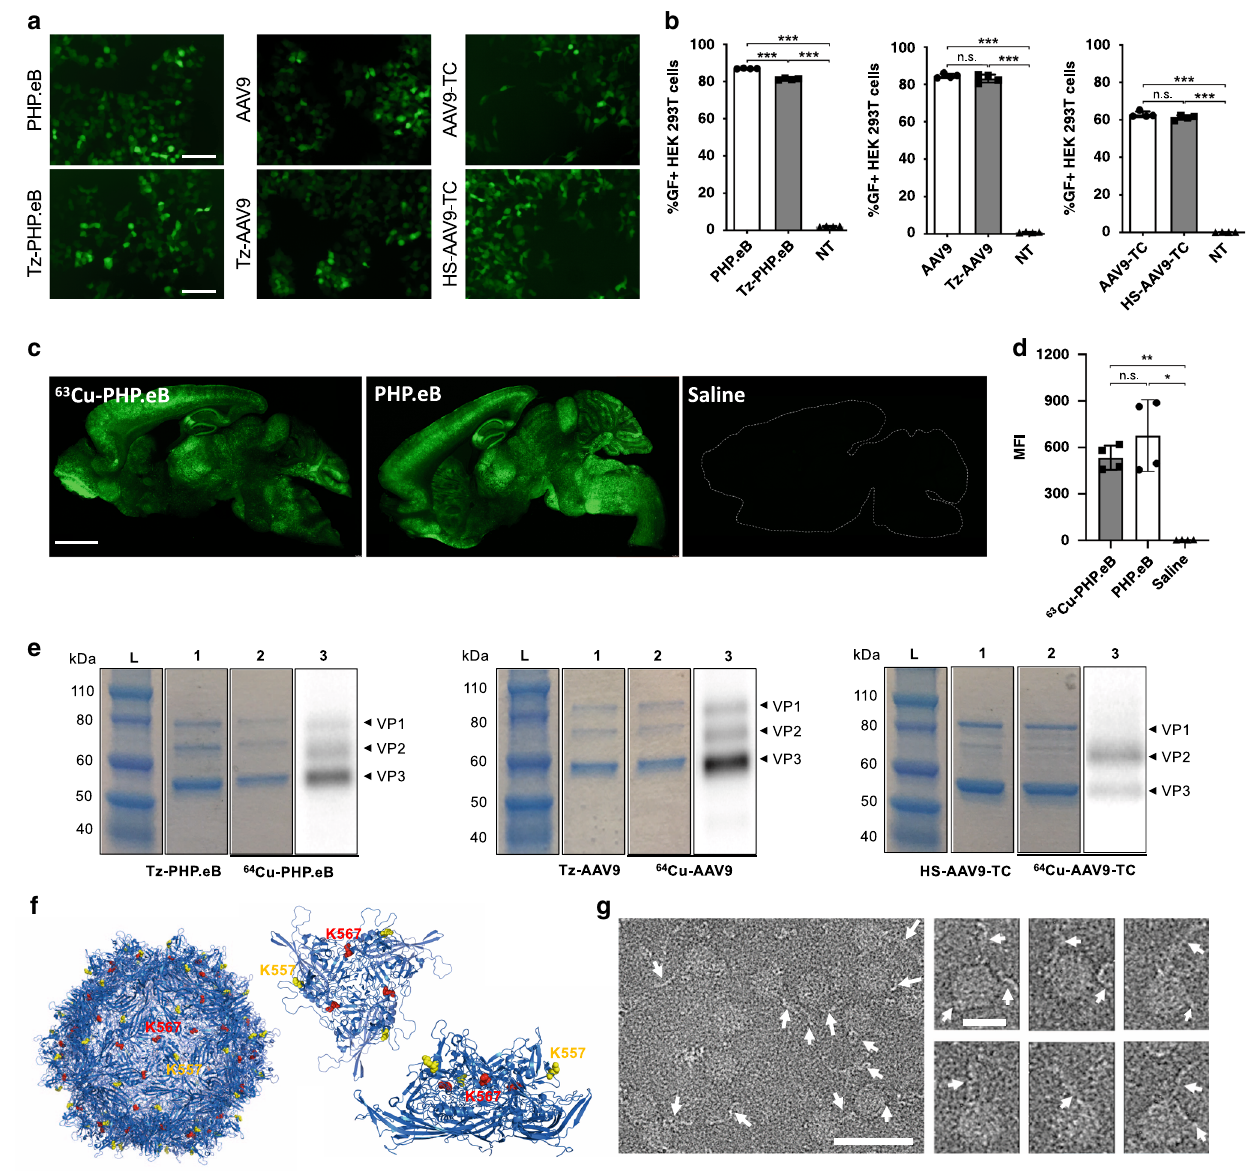
Fig. 2 Transduction and labeling ef fi ciency of surface modi fi ed AAVs. a Fluorescence microscopy images of human embryonic kidney(HEK) 293T cells after 24 h incubation with intact AAVs (upper row, PHP.eB, AAV9, and AAV9-TC) and corresponding modi fi ed AAVs (lower row, Tz-PHP.eB, Tz-AAV9, and HS-AAV9-TC) at 1 × 10 6 AAV/cell. b Percentage of green fl uorescent positive (GF + ) HEK293T cells 2 days after incubation with unmodi fi ed AAVs (PHP.eB, AAV9, and AAV9-TC, white bar with black circles) and the corresponding modi fi ed AAVs (gray bar with black squares), assessed by fl ow cytometry. The frequency of GF + cells treated with unmodi fi ed and modi fi ed AAVs was similar and distinct from non-treated (NT, black triangles) cells ( n = 4 per group). c Representative GFP images of sagittal brain sections from a C57BL/6 mouse at 3 weeks after tail vein administration of 63 Cu-PHP.eB, PHP.eB (1.5 × 10 10 vg) or saline (negative control) and d mean fl uorescence intensity (MFI) of sagittal brain sections ( 63 Cu-PHP.eB: gray bar with black squares, PHP.eB: white bar with black circles, saline: black triangles, n = 4). e SDS-PAGE of modi fi ed AAVs (Tz-PHP.eB, Tz-AAV9, and HS-AAV9-TC; lane 1) and radiolabeled AAVs ( 64 Cu-PHP.eB, 64 Cu-AAV9, and 64 Cu-AAV9-TC; lane 2 and 3). The three bands depict viral protein (VP) 1 – 3 (L: standard protein ladder). Lane 1 – 3 illustrate blue-stained VPs (lanes 1 and 2) and radiolabeled VPs (lane 3), respectively. f Illustration of AAV9 capsid with modi fi ed lysines. Left: full view of AAV9, middle and right: top and side views of trimer viral proteins, respectively. The K557 (yellow) and K567 (red) lysine residues are highlighted. g Field view of direct-electron cryoEM images of PEG(40 kDa)-AAV9 (left image) and enhanced projection images of selected PEG(40 kDa)-AAV9 capsids (six right images). White arrows mark the 40 kDa PEG molecules extended from the selected AAV capsids. Data are shown as mean ± SD. Brown-Forsythe and Welch ANOVA with Dunnett ’ s T3 multiple comparison test compares means ( b , d ). Signi fi cance is presented as n.s. (not signi fi cant), * P ≤ 0.05, ** P ≤ 0.01, and *** P ≤ 0.001. Whole gel and gel autoradiography images and P values are shown in the source data. Scale bars: 100 μ m ( a ), 2 mm ( c ), 50 nm ( g , left), 20 nm ( g ,